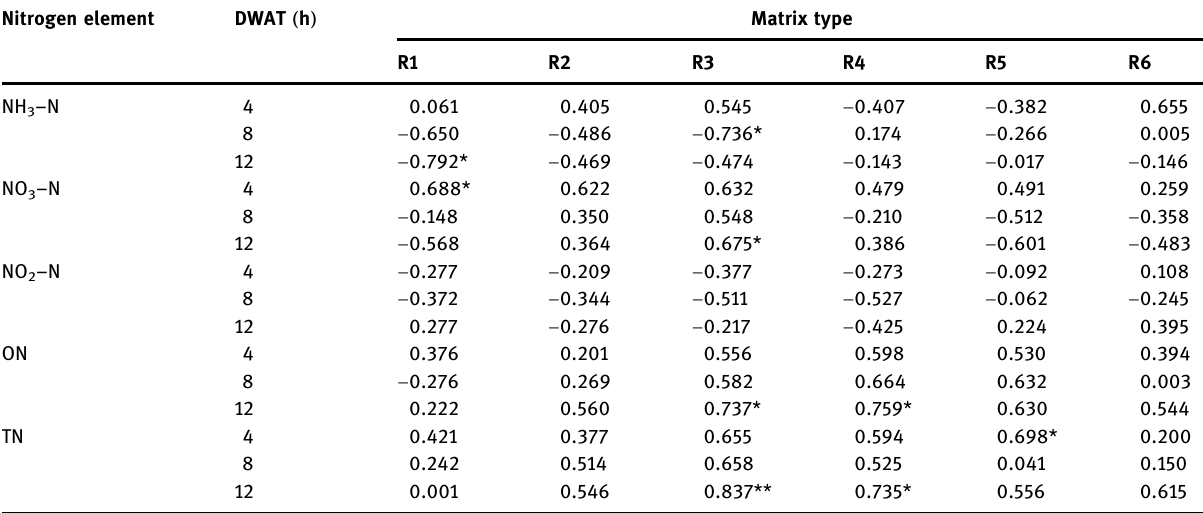
Table 2: Correlation between DO and nitrogen removal rate Nitrogen element DWAT ( h ) Matrix type